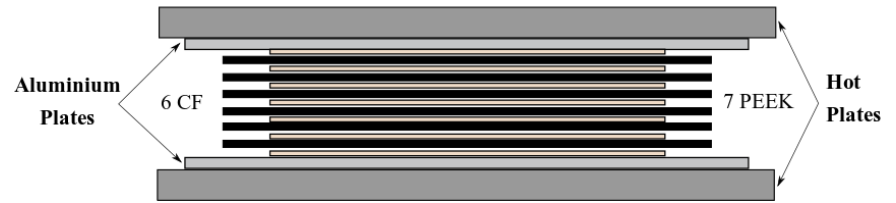
Figure 2. Multilayer setup for the laminate consolidation with a hot plate